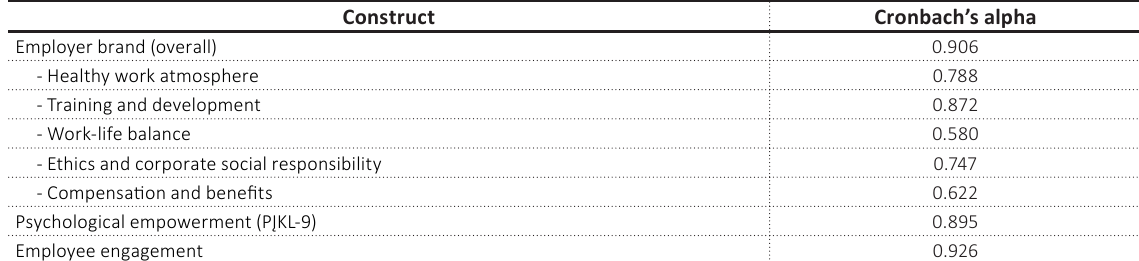
Table 1. Reliability